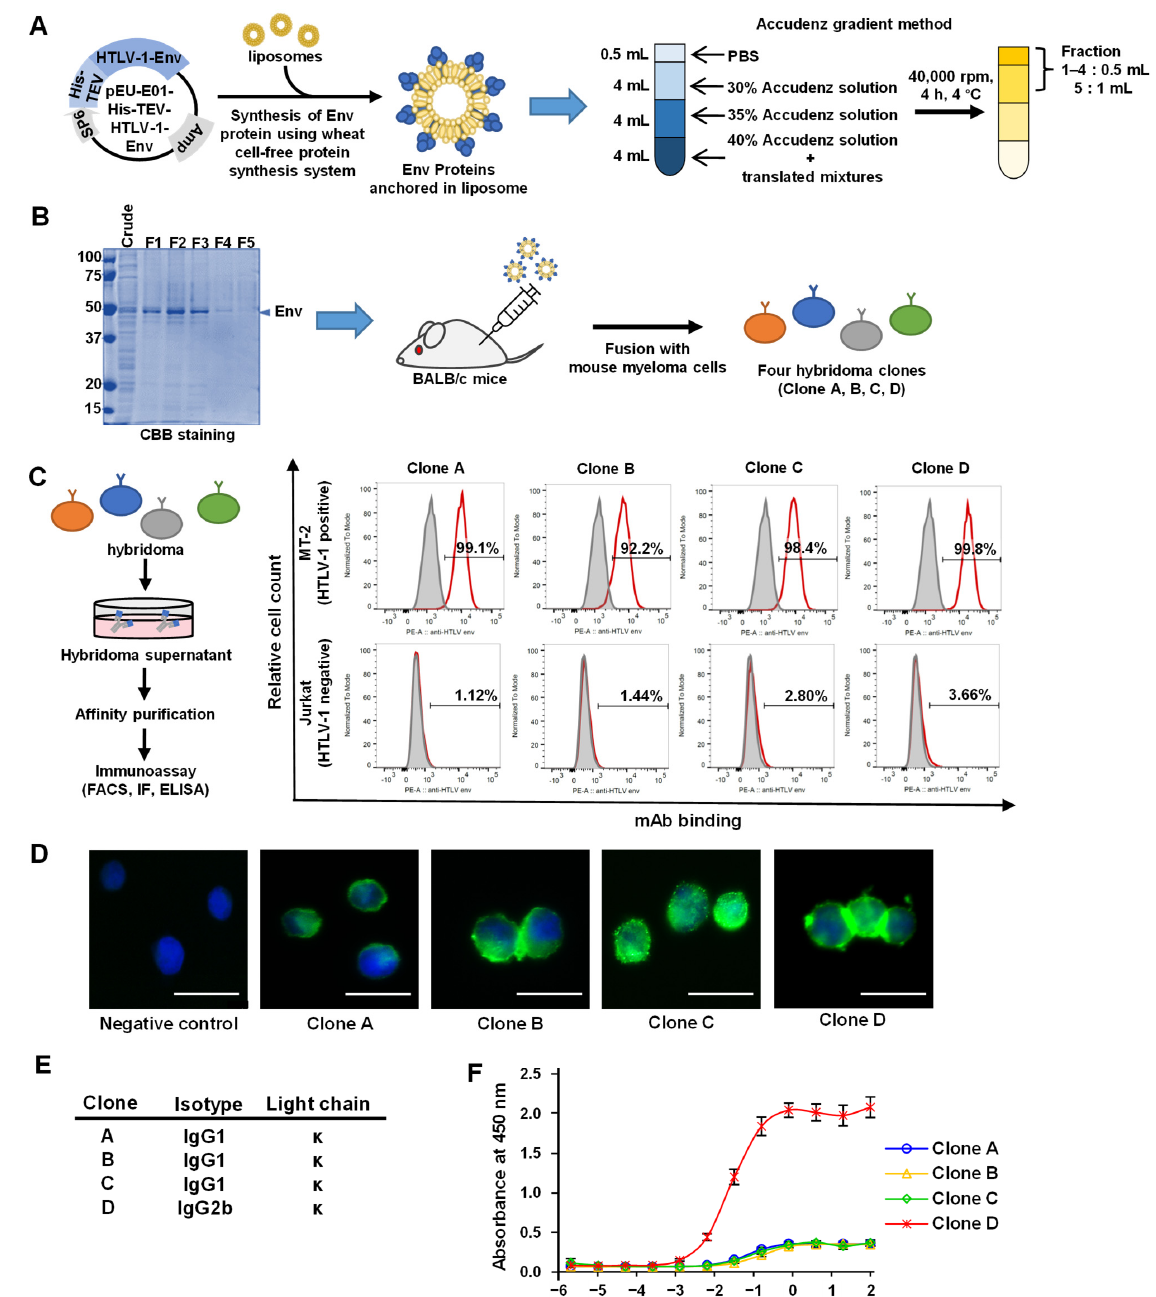
Figure 1. Synthesis of the His-HTLV-1 Env protein and production of anti-HTLV-1 Env mAbs: ( A , B ) a scheme showing the production of hybridoma cells to generate anti-HTLV-1 Env mAbs; ( A ) the gene encoding the HTLV-1 Env protein (composed of gp46 and gp21) was cloned into the pEU-His vector and His-HTLV-1 Env proteins anchored in the liposome synthesized using a wheat germ